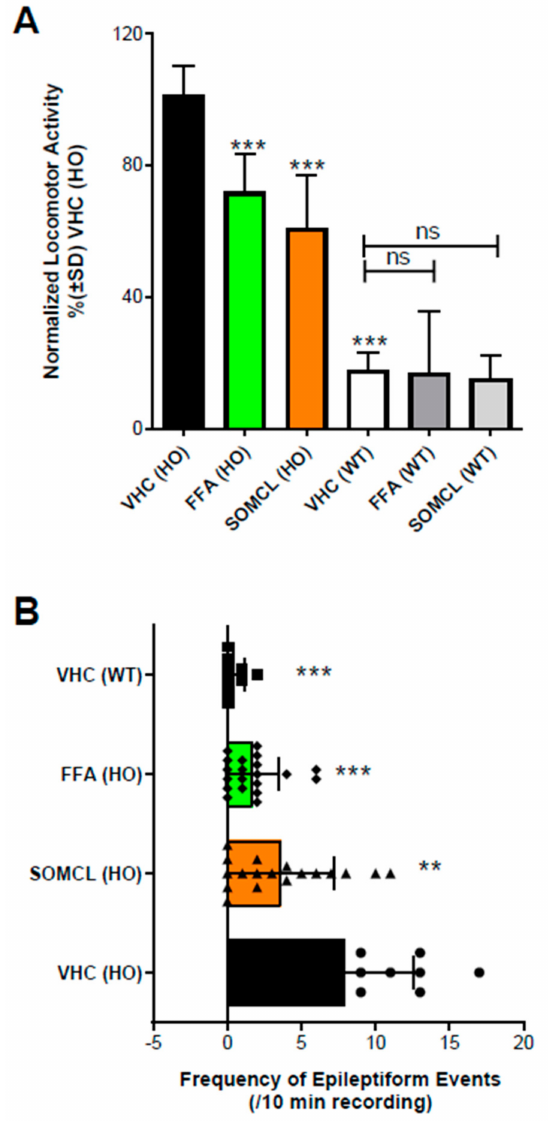
Figure 3. Activity profile of SOMCL-668 (SOMCL, 10 µ M) and fenfluramine (FFA, 25 µ M) in 7 dpf zebrafish larvae. ( A ) Treatment with SOMCL or FFA decreases the locomotor activity of 7 dpf scn1Lab − / − mutants (HO), but not wildtype (WT). Locomotor activity was normalized against VHC-treated scn1Lab − / − mutant larvae and is displayed as percentage ± SD. N = 30 to 60 zebrafish larvae for all experimental conditions. ( B ) Treatment with SOMCL and FFA reduces the epileptiform brain activity of 7 dpf scn1Lab − / − mutants (HO). The bars represent the numbers of epileptiform events (during 10 min of recording; ± SD) of homozygous scn1Lab − / − mutants (HO) or wildtype scn1Lab+/+ (WT) treated with vehicle (VHC) or SOMCL or FFA, compared to the outcome observed in VHC-treated homozygous scn1a mutants, vehicle control (VHC [HO]). N = 9 to 18 zebrafish larvae for all experimental conditions. Overall, statistical significance is represented by asterisks: ** p < 0.01, and *** p < 0.001 vs. VHC (HO). “No statistical difference” is left blank or is shown by “ns”. Statistical analyses: GraphPad Prism 5 software (GraphPad Software, Inc., San Diego, CA, USA) was used for statistical analyses. ( A ) Locomotor activity was analyzed by one-way ANOVA and subsequent Dunnett’s multiple comparison tests, as described in Sourbron 2016 and 2017 [23,30]. ( B ) Electrographic brain activity was analyzed by Mann-Whitney U tests, as was described in Sourbron 2016 and 2017